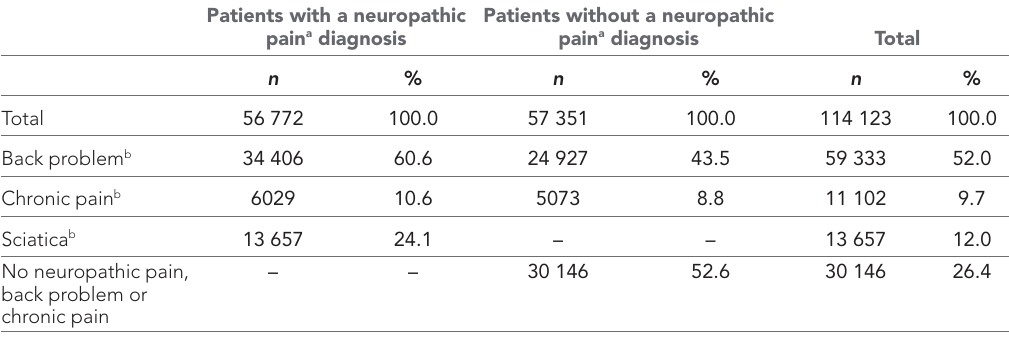
Table 2 Pain diagnoses and conditions recorded during study period, March 2012–February